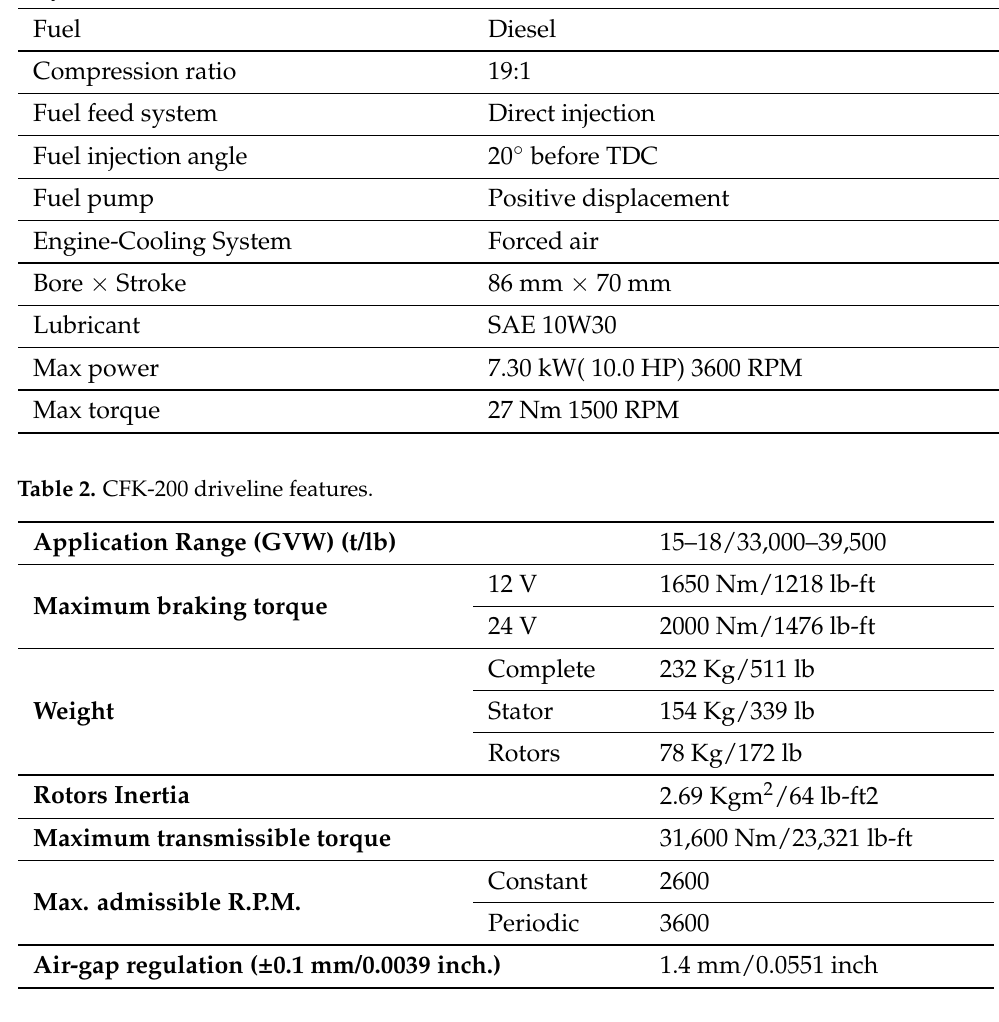
Table 3. Spark plug pressure sensor